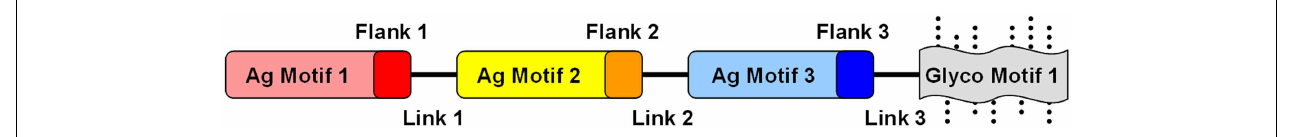
strategic linker domains ( Link ) in a fusion construct. By virtue of its expression in a strategic heterologous system, glycosylation motifs ( Glyco motif ) or lack thereof would be favored to stimulate or target immune pattern recognition receptors (PRRs) to evoke optimal responses for protective